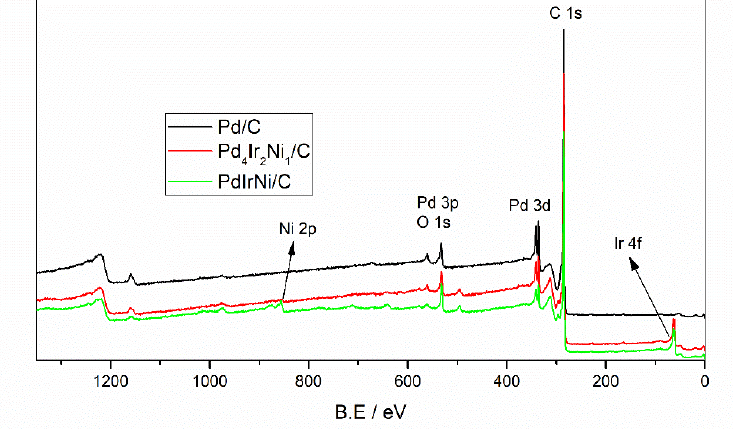
4 Ir 2 Ni 1 /C ( C ).